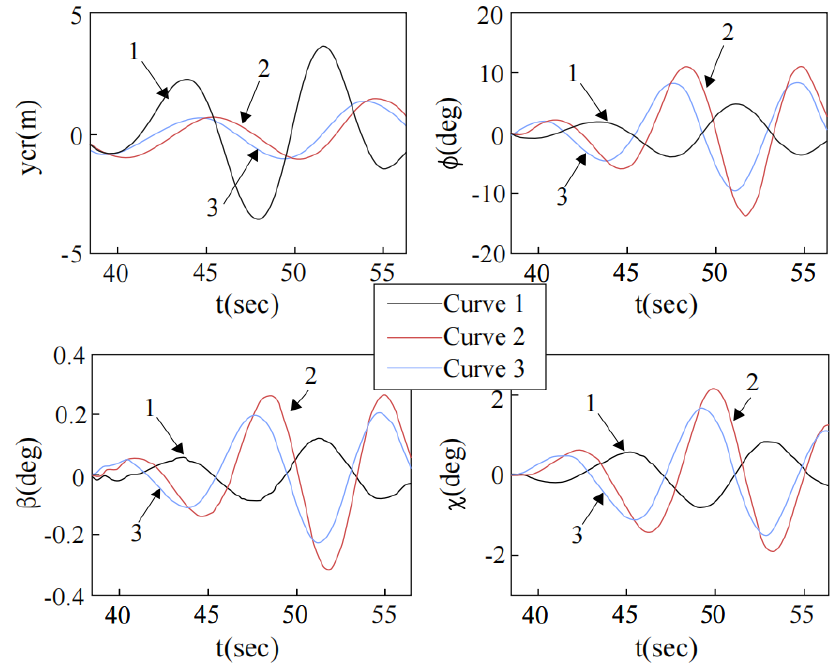
Figure 45. The deck motion compensation curves with integral and inertial tracking strategies.